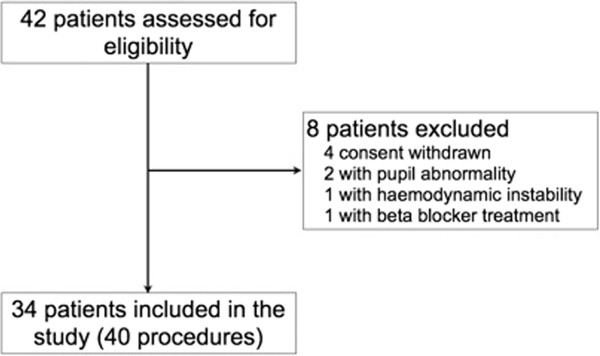
Flow diagram of included patients.